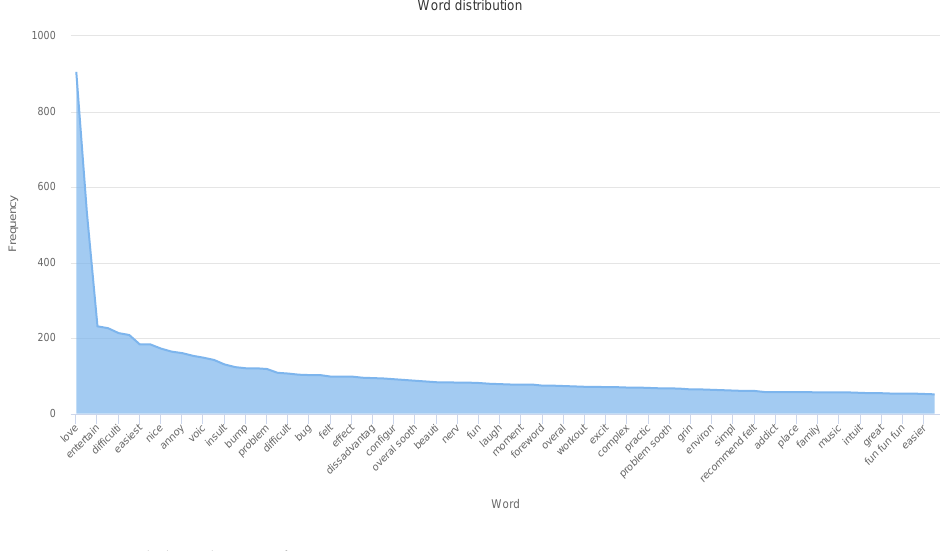
Figure 13. Word distribution for games